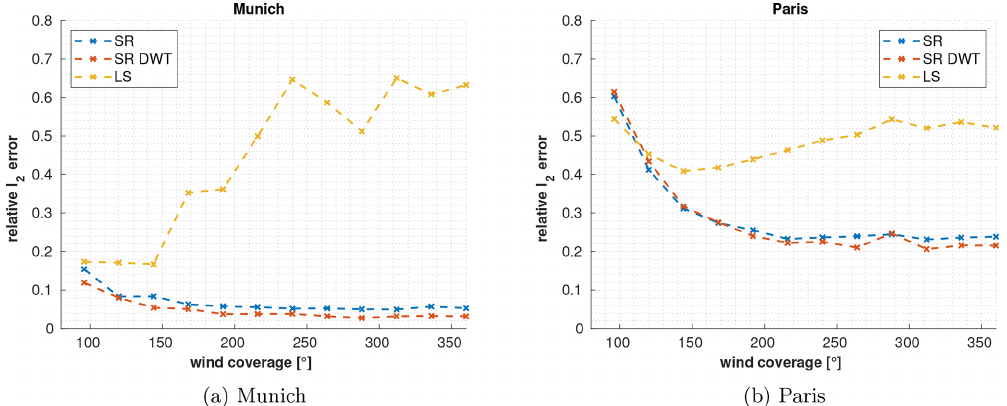
Figure 5. Estimation errors for SR in the spatial and wavelet domain and LS reconstruction of (a) Munich’s and (b) Paris’s emissions with footprints covering different amount of wind directions. With a higher wind coverage, the estimation result using SR improves. The LS has no clear improvement for higher wind coverages, but its performance decreases with high coverages for Munich, while for Paris the performance first increases until about a coverage of 150 ◦ before decreasing again.